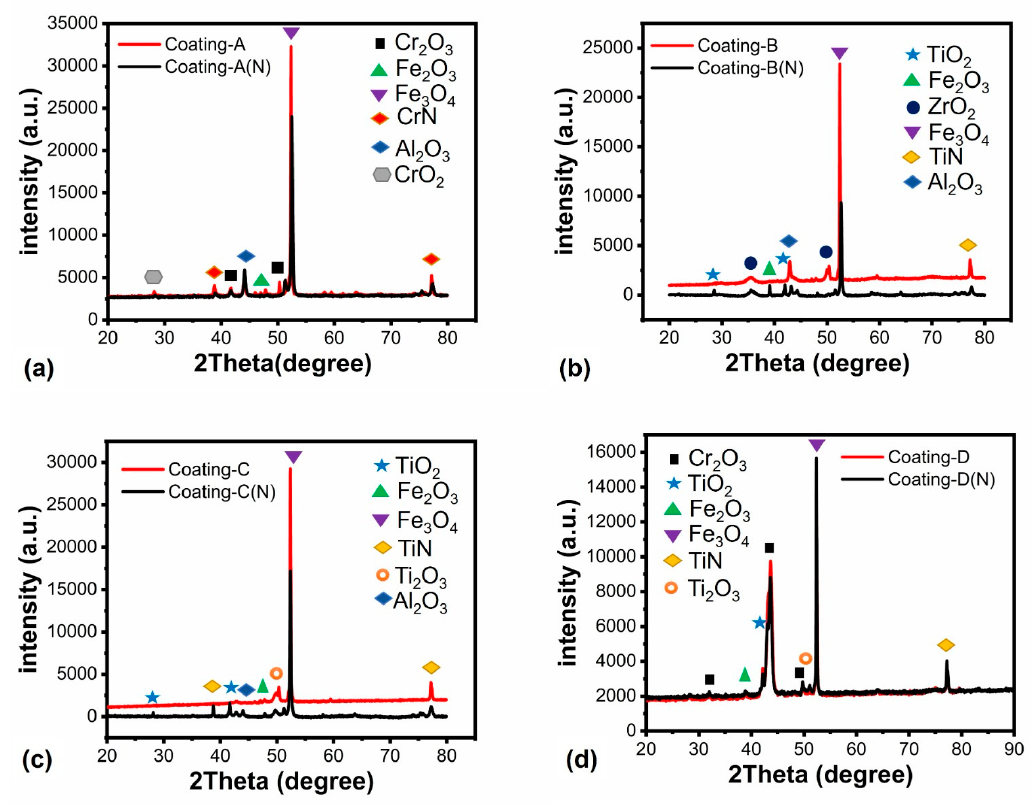
Figure 13. Phase analysis of the coatings after elevated temperature tests, XRD: ( a ) coating A; ( b ) coating B; ( c ) coating C and ( d ) coating D.